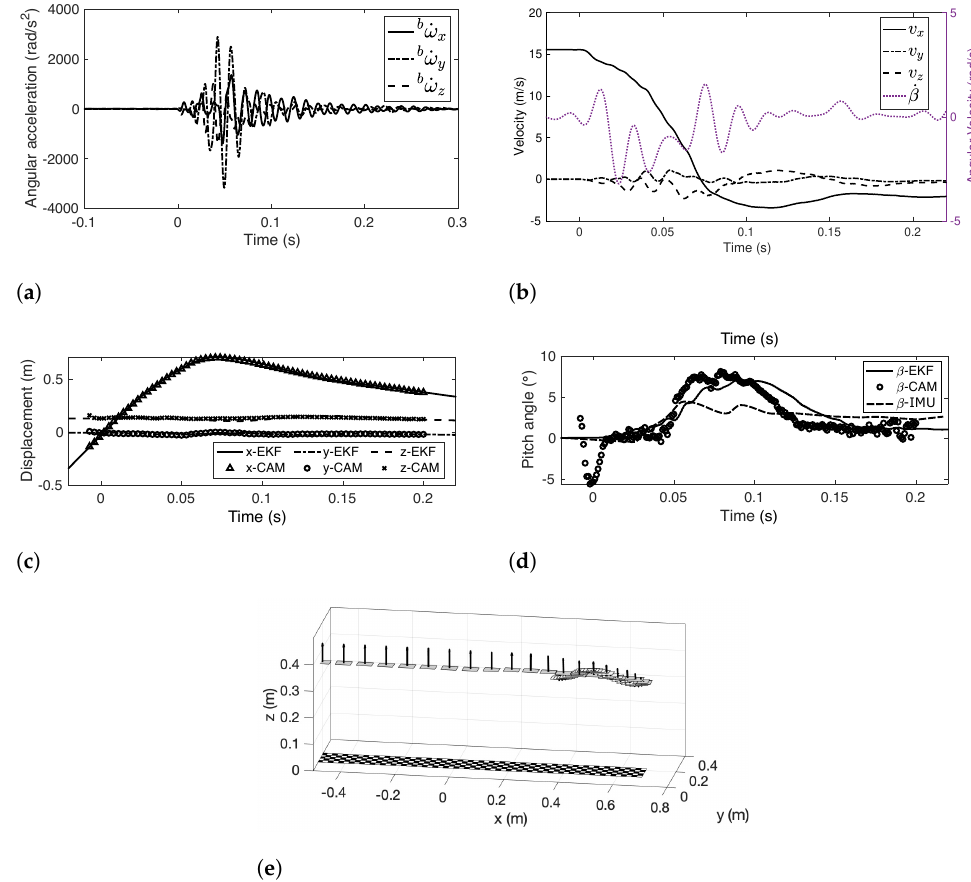
Figure 11. Frontal barrier localization result. ( a ) Displacement of the camera fixture. ( b ) Pitch angle of the camera fixture. ( c ) Localization of camera fixture in the global